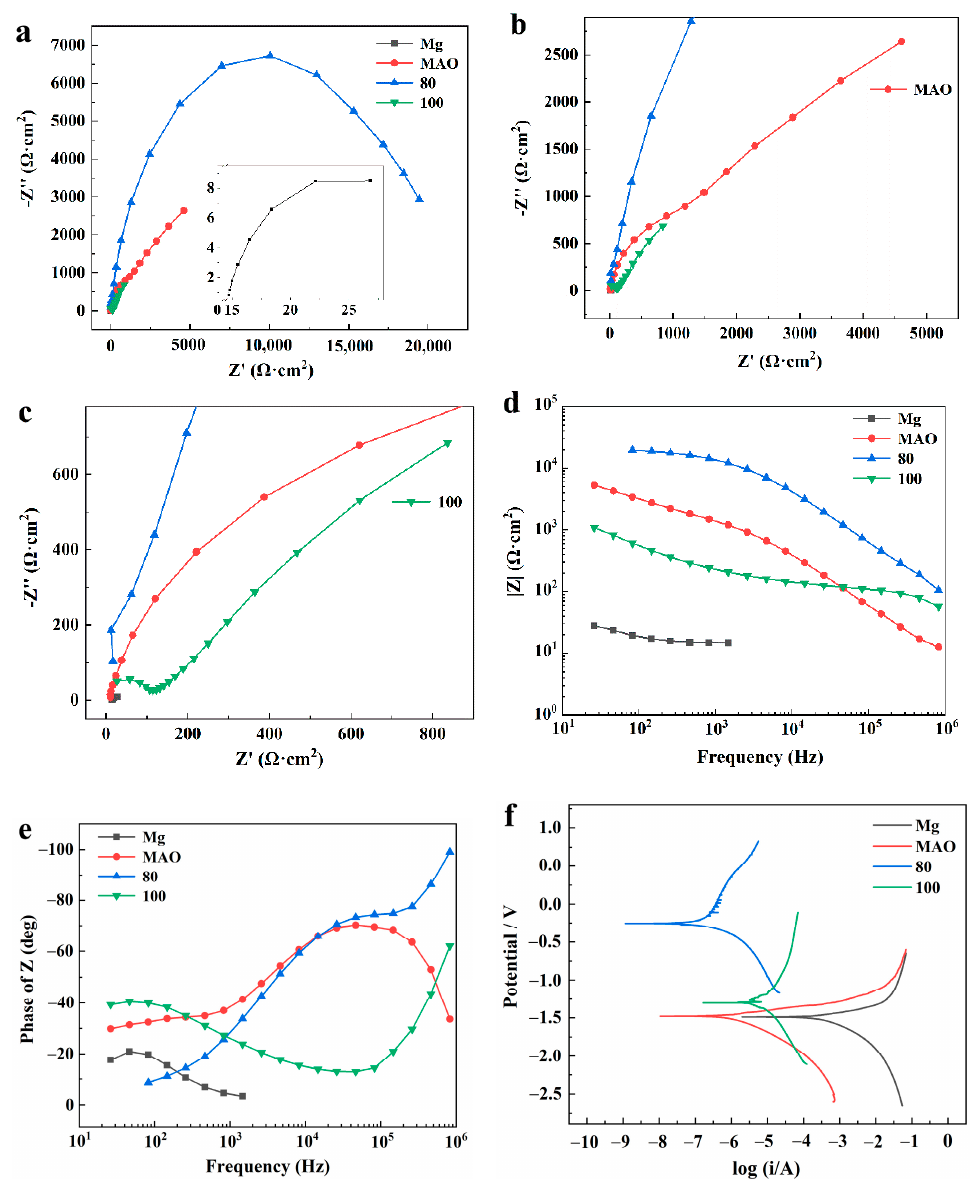
Figure 10. EIS and polarization curves of the Mg, micro-arc oxidation, 80, and 100 wt% samples: ( a – c ) Nyquist, ( d ) Bode of |Z|, ( e ) Bode of the phase, and ( f ) polarization curves.